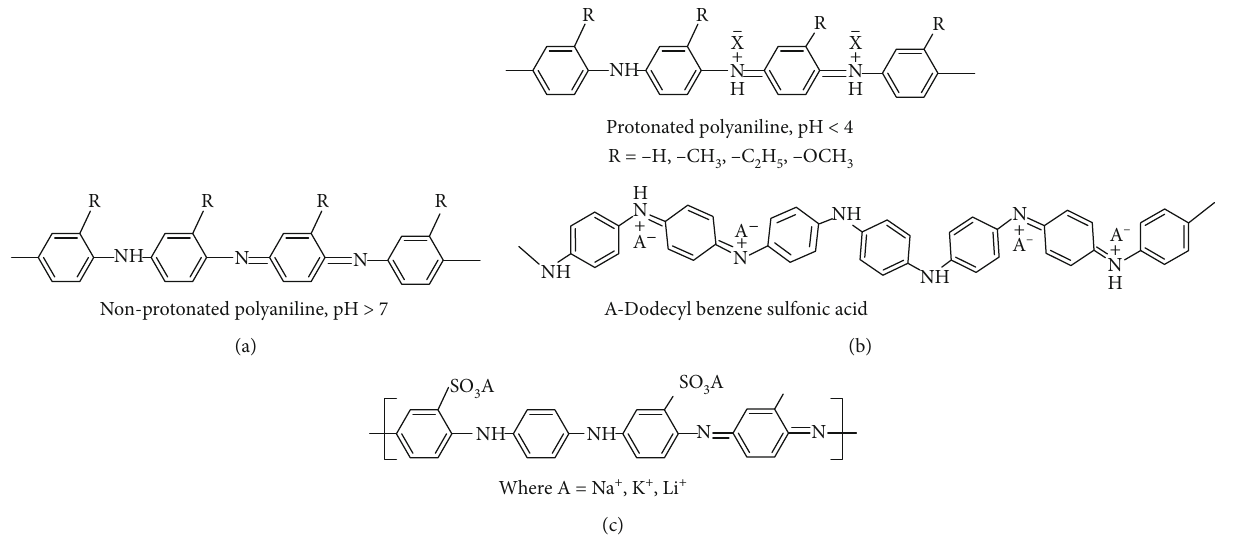
Figure 2: Structure of (a) simple, (b) modi fi ed, and (c) water-soluble